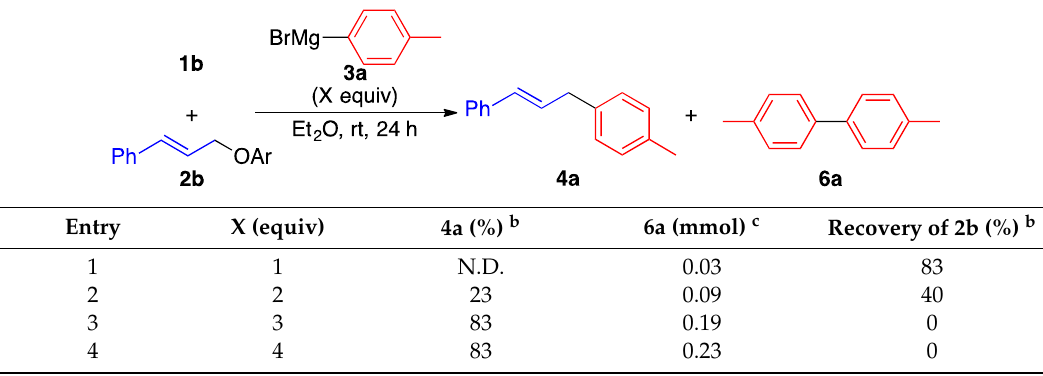
Molecules 2019 , 24 FOR PEER REVIEW